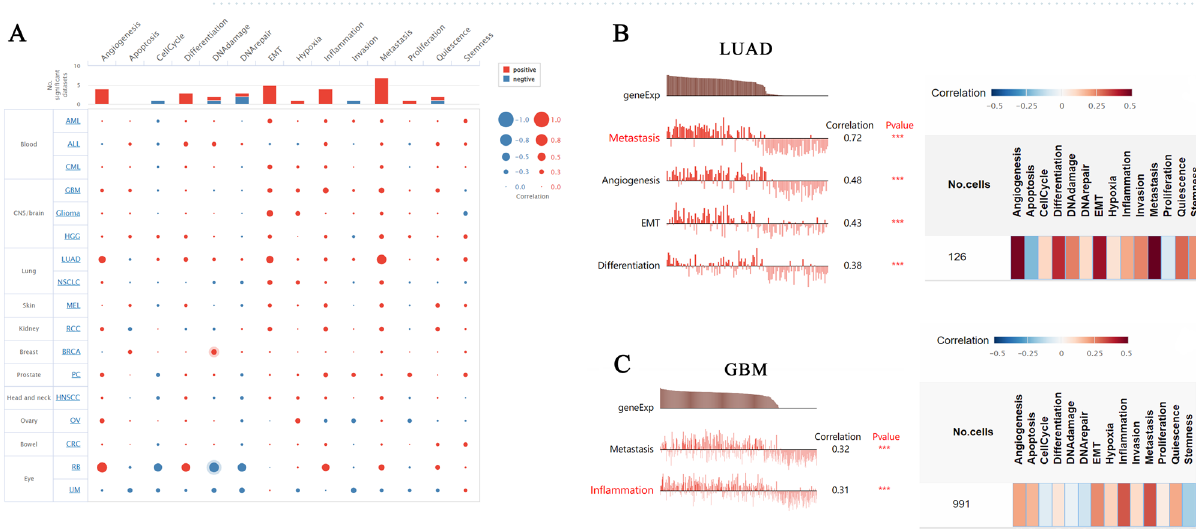
Figure 6. The correlation of CD44 with the functional state in cancers. The interactive bubble chart presents the correlation of CD44 with the functional state in 17 cancers ( A ). The correlation of CD44 with functional state in LUAD ( B ), GBM ( C ). LUAD lung adenocarcinoma, GBM glioblastoma multiforme. *** P <